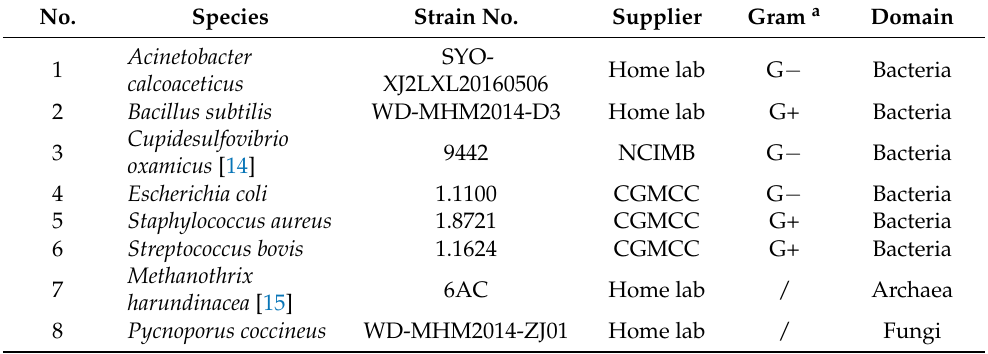
Table 1. Strains for